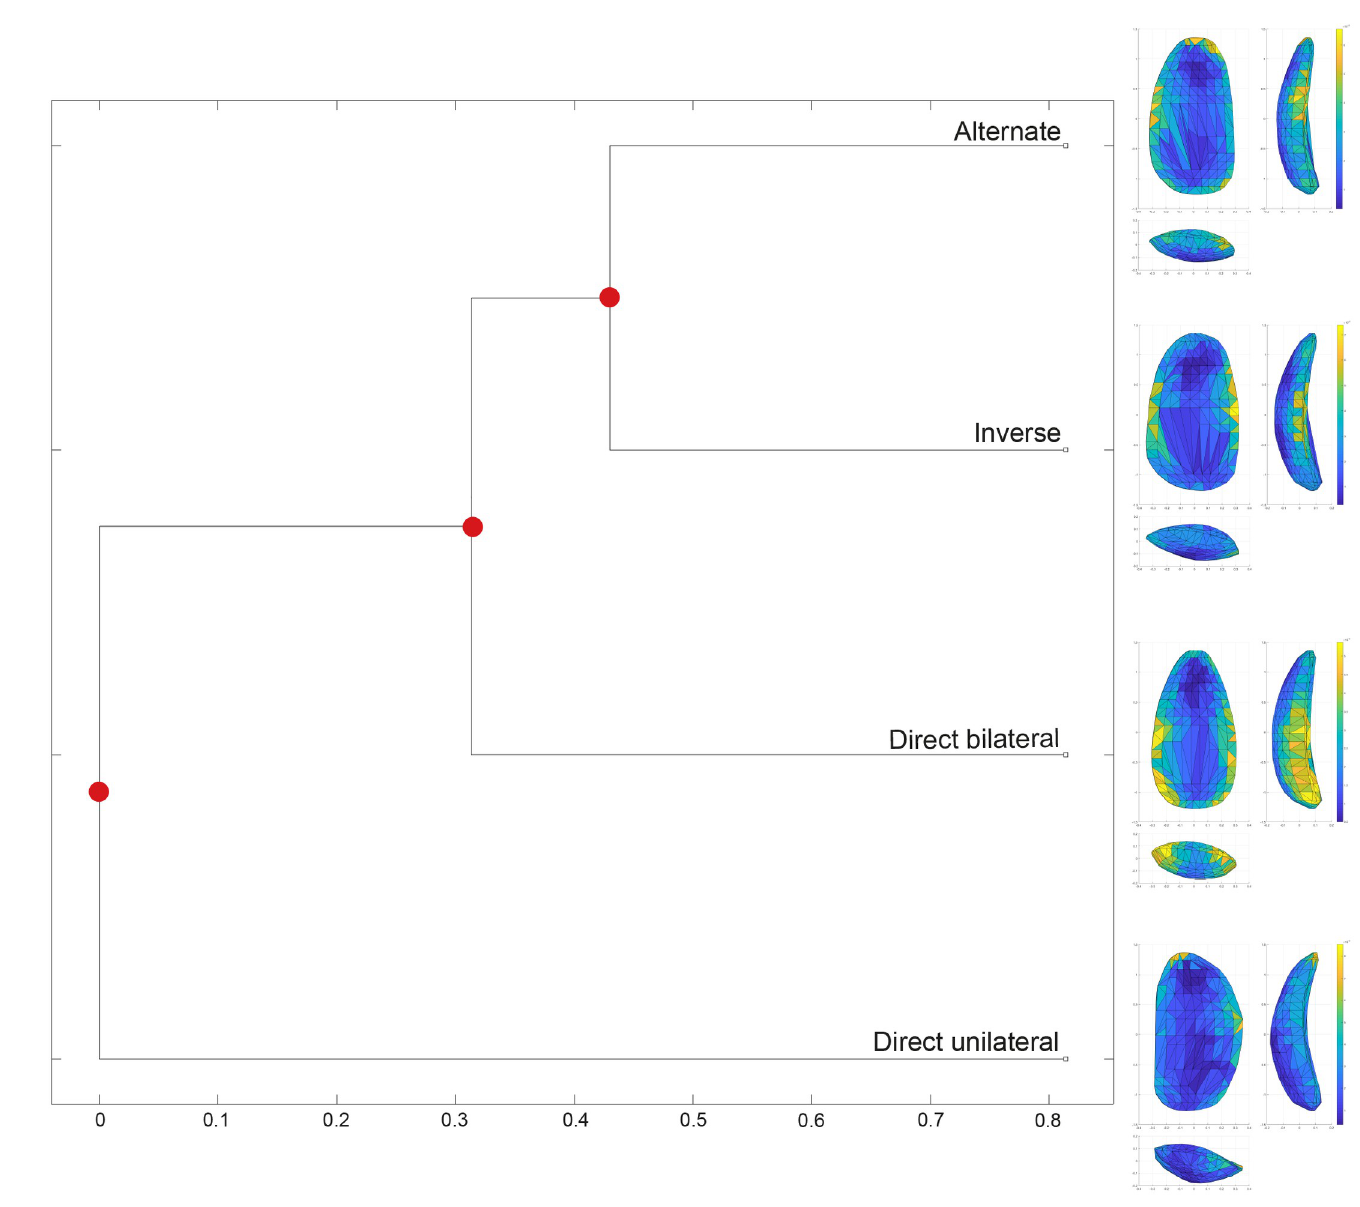
Fig 6. Dendrogram representing the distance between the centroids of retouched bladelets sorted according to retouch position. The mean shapes for each group are also reported. The color coding of the mean shapes represents the spatial distribution of variability within each group.